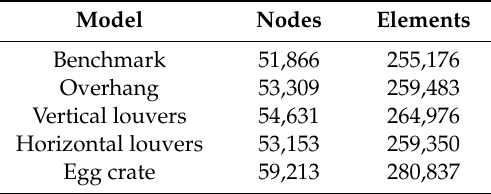
Table 7. Meshing nodes and elements.